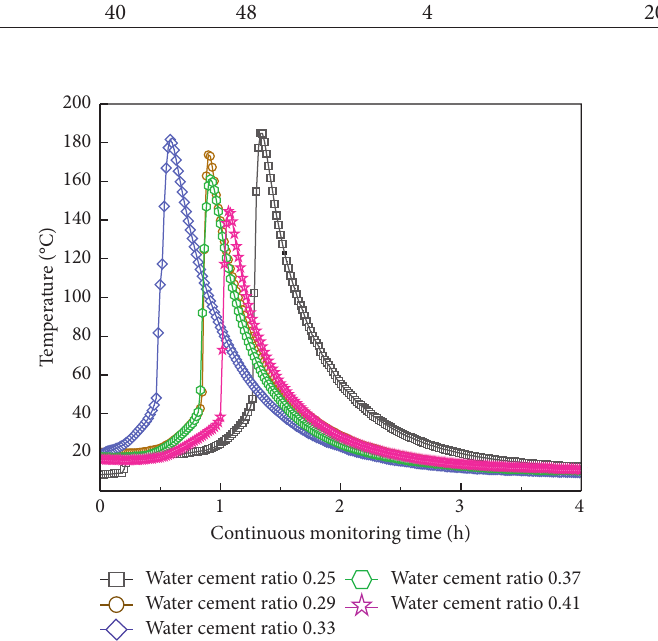
Figure 6: Temperature change characteristics at various water-cement